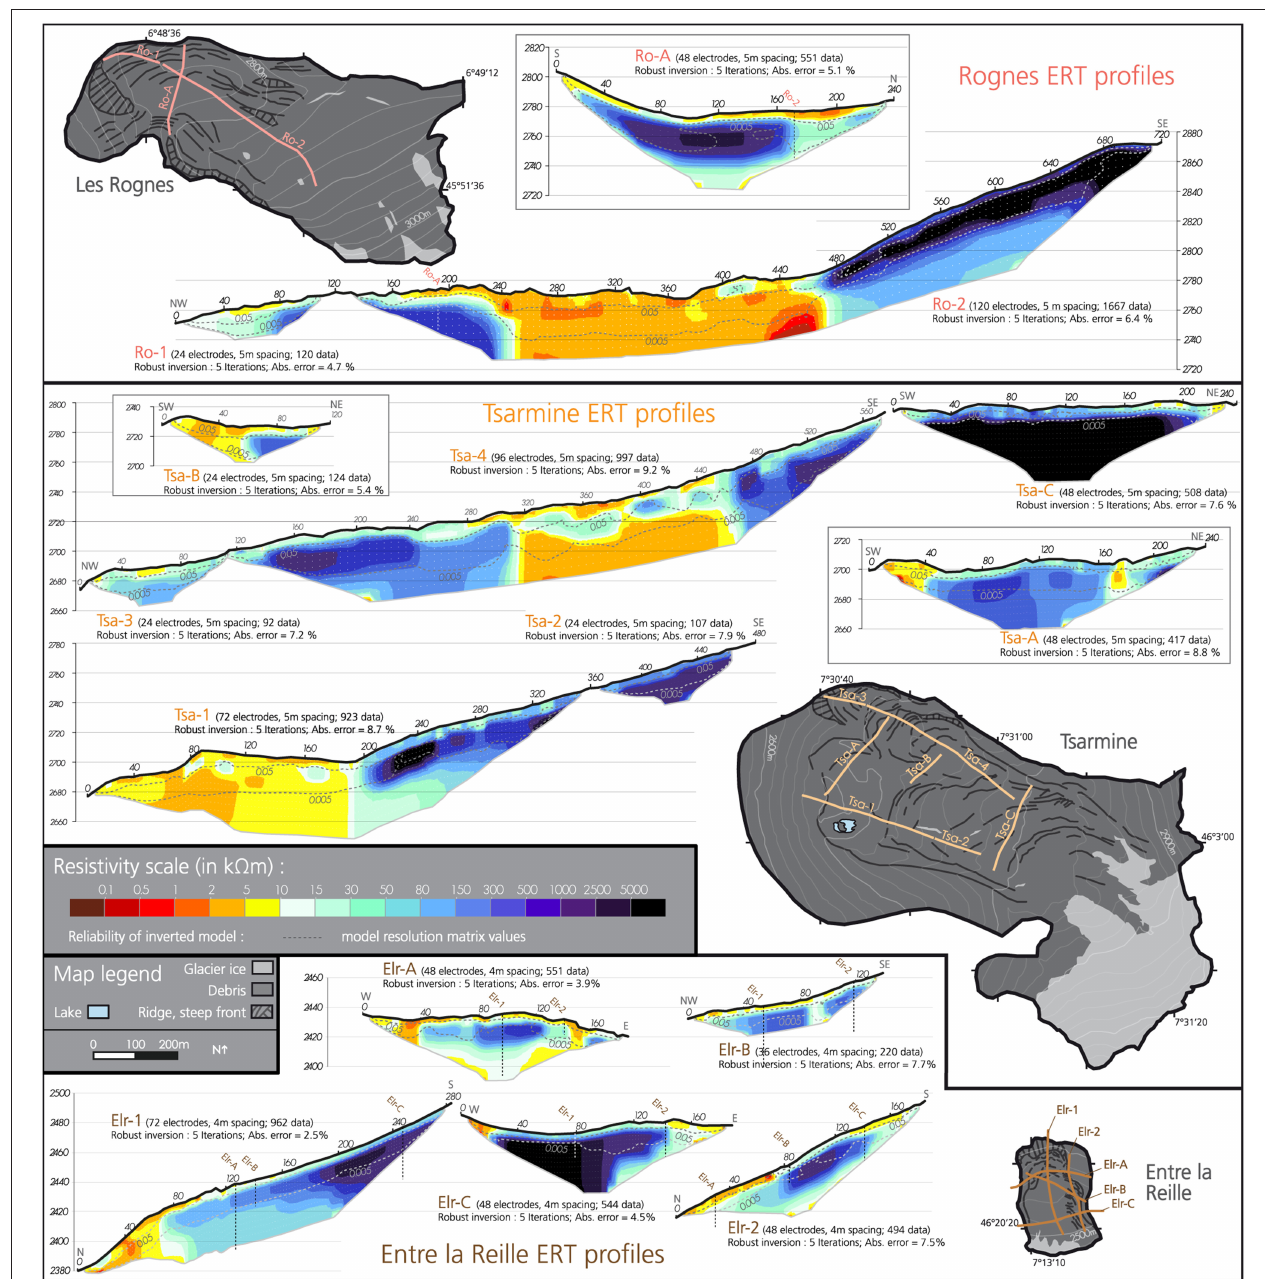
FIGURE 5 | Longitudinal (1, 2, 3, and 4) and transversal (A, B, and C) electrical resistivity tomograms (ERT) profiles obtained in August 2012 at les Rognes, in August 2014 at Tsarmine and between 2011 and 2013 at Entre la Reille.